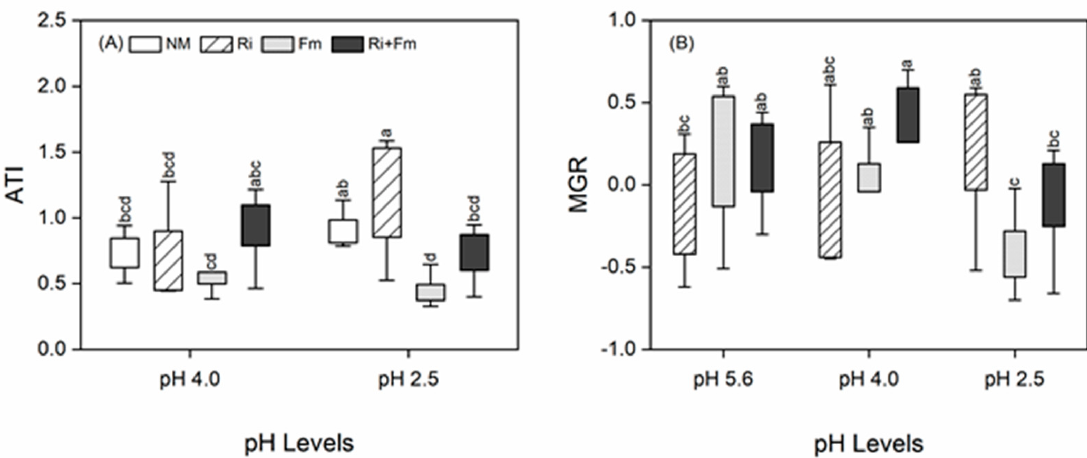
Figure 6. Effects of arbuscular mycorrhizal fungi on acid − tolerance index (ATI) ( A ) and mycorrhizal growth response (MGR) ( B ) of Torreya grandis under acid rain with pH 5.6, 4.0, and 2.5. NM, Ri, Fm, and Ri+Fm represent the four AMF treatments: inoculation with no mycorrhizal fungi, with Rhizophagus irregularis, with Funneliformis mosseae , and with the combination of the two fungi inoculum, respectively. Values are presented as the mean ± SE ( n = 6). Different letters indicate a significant difference ( p < 0.05).